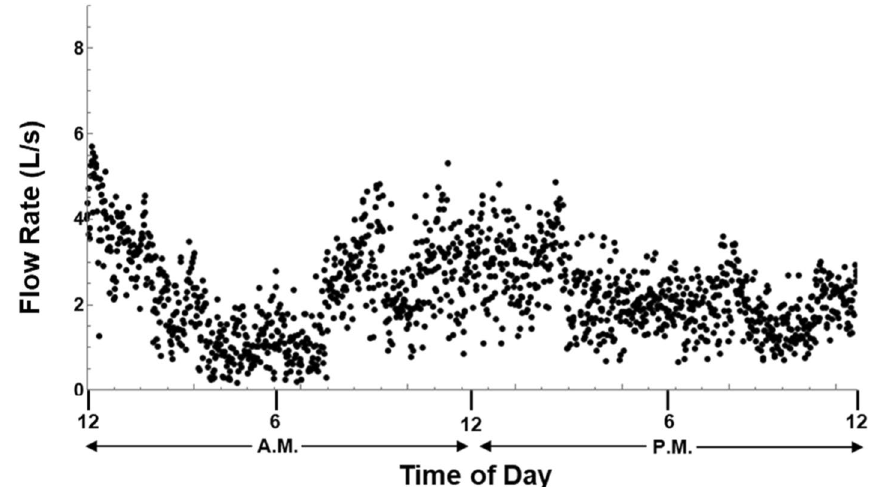
Fig. 10 Tuesday average readings for daily